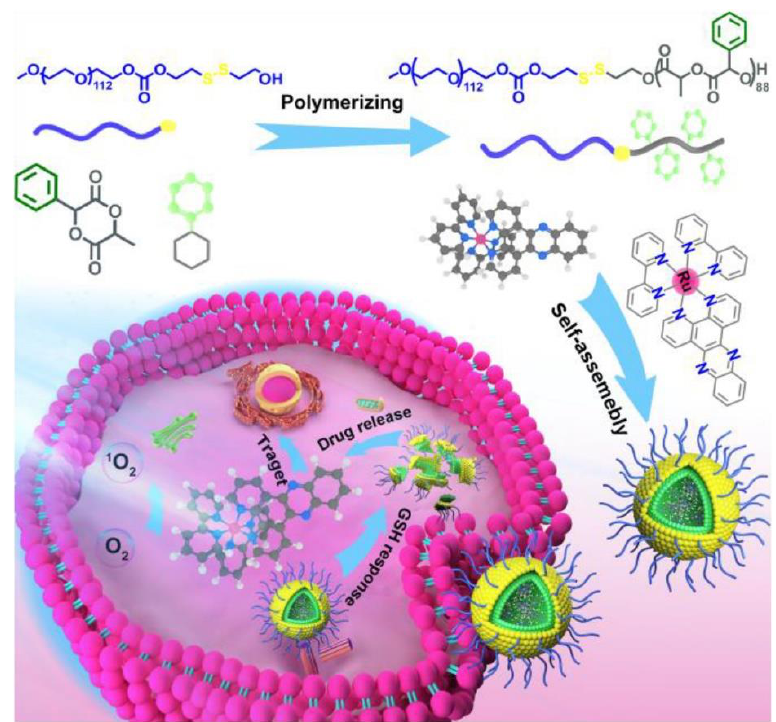
Figure 4. Schematic illustration of biodegradable Ru-containing polylactide MPEG-SS-PMLA@Ru micelles for enhanced Ru(II) polypyridyl complexes delivery and cancer phototherapy. (Adpated with copyright permission from [27]. 2022, American Chemical Society).